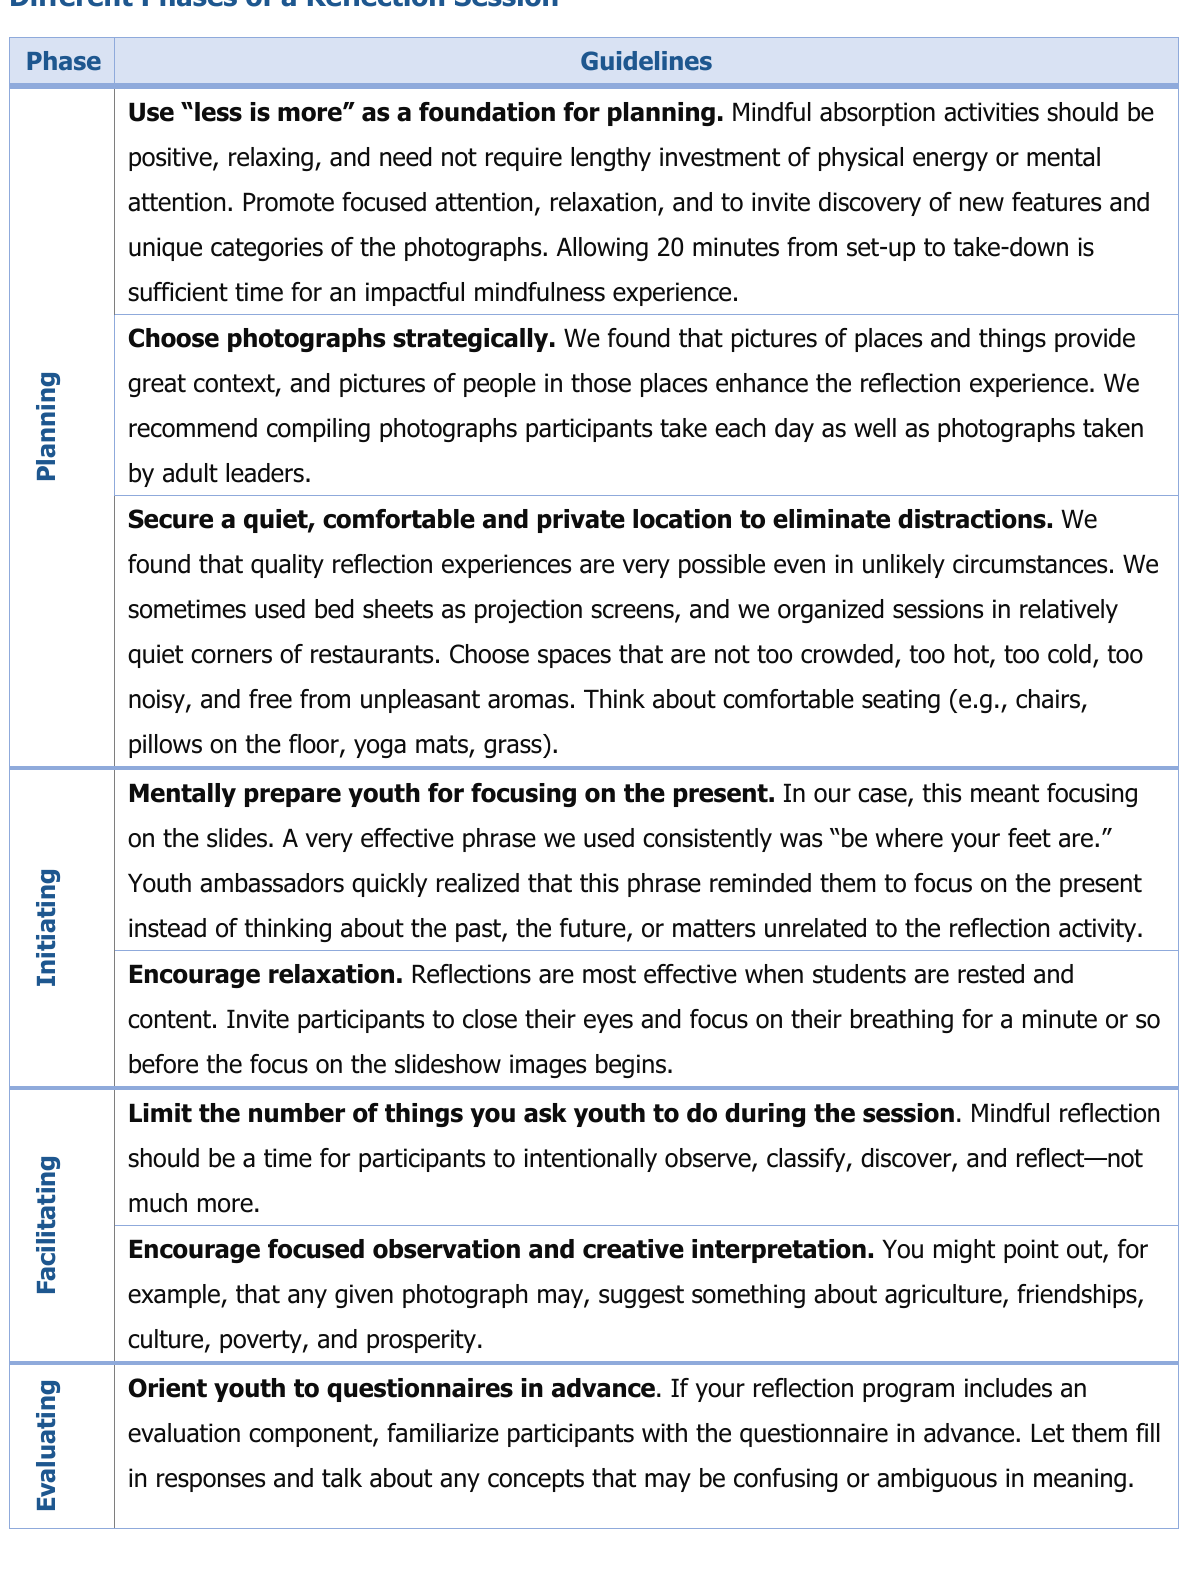
Table 1. Guidelines for Structuring a Guided Reflections Program for Youth at Different Phases of a Reflection